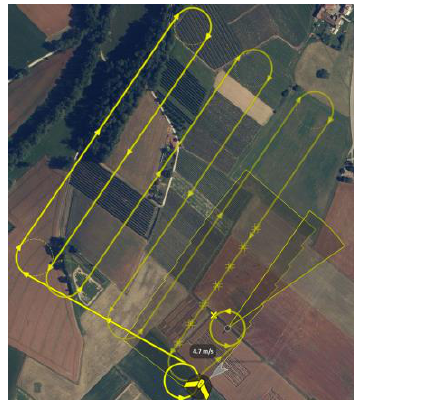
Figure 3. Homogeneous surface with low number of detectable objects